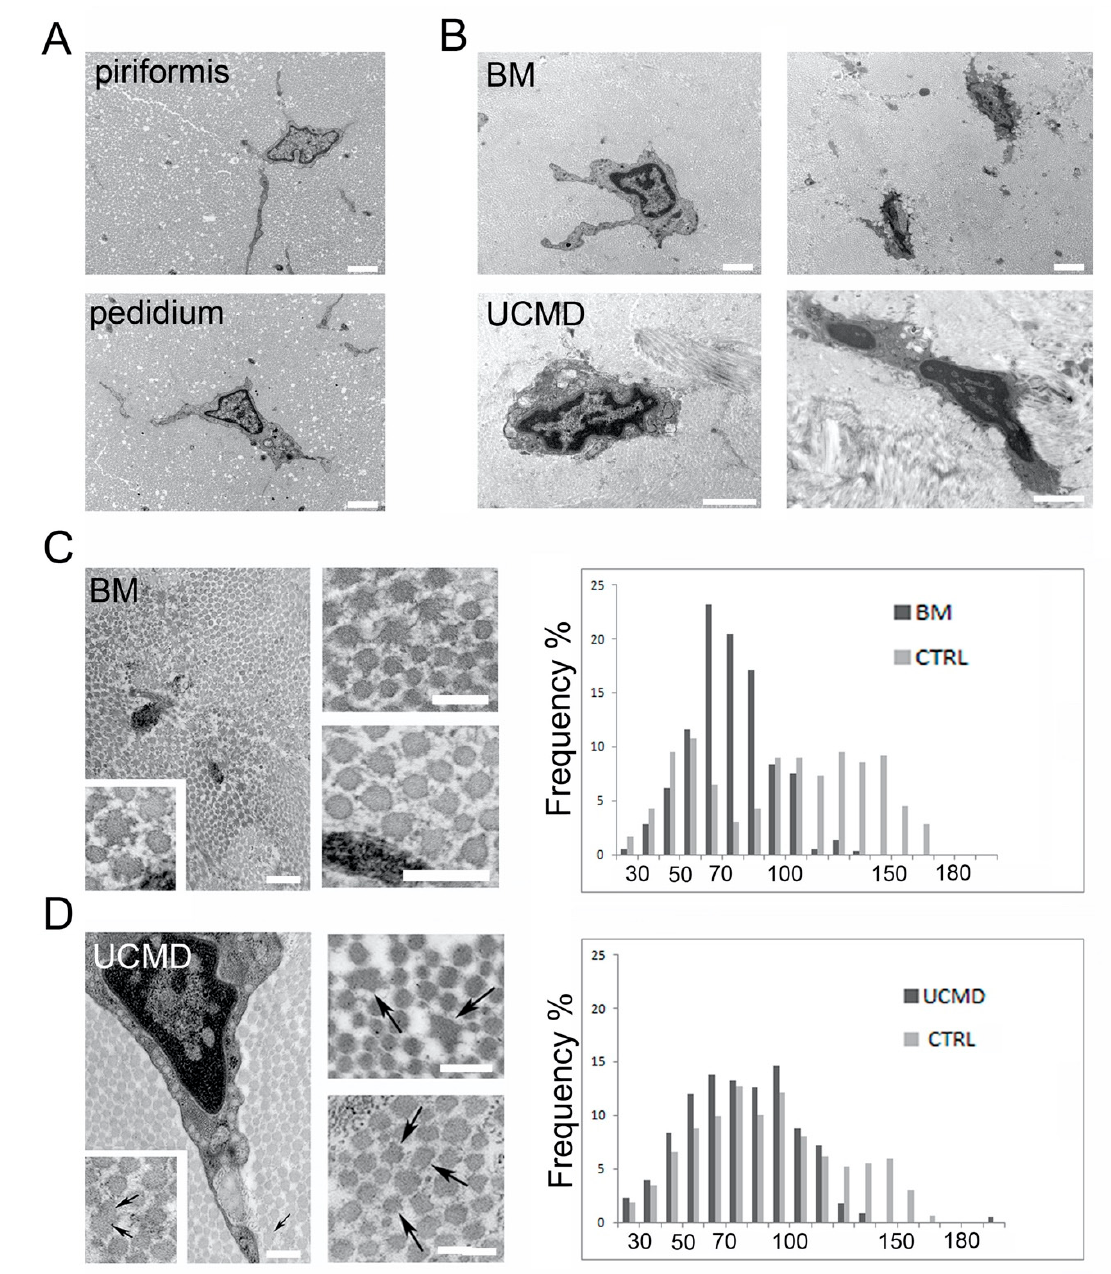
Figure 5. Transmission electron microscopy analysis of tendon biopsies. ( A ) Ultrastructural analysis of normal piriformis and pedidium tendon showing long cellular processes. Scale bar, 1 μ m. ( B ) BM and UCMD tenocytes displaying reduced and irregular cellular processes. Necrotic cell with hypercondensed heterochromatin and vacuoles is shown (upper and lower lane, right panels). Scale bar, 1 μ m. ( C ) Transmission electron microscopy of cross-sectioned BM piriformis tendon showing altered fibrils with irregular profiles and a ragged appearance (inset). Scale bar, 1 μ m. 60 nm. ( D ) UCMD pedidium tendon with altered fibrils (arrows) showing irregular profile. Scale bar, 1 μ m. 60 nm.